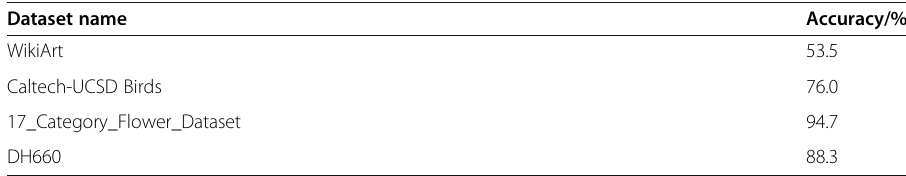
Table 8 Accuracy of the model for each dataset